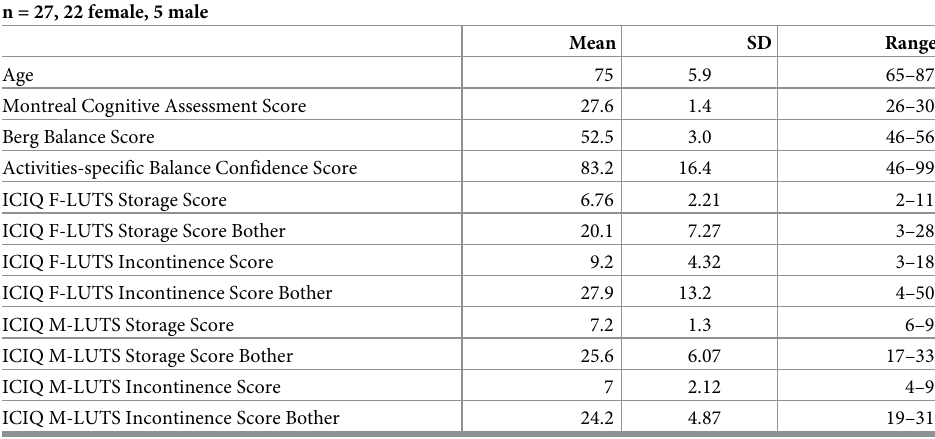
n = 27, 22 female, 5